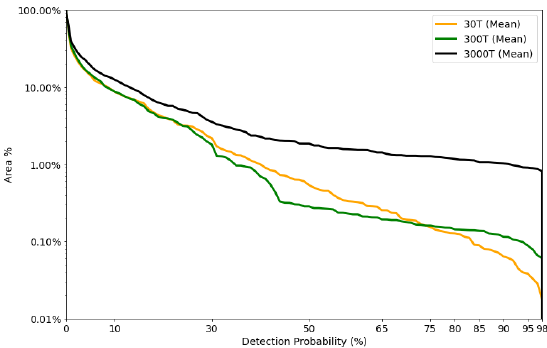
Figure 10. Mean detection probability plotted vs. the total area covered at specific